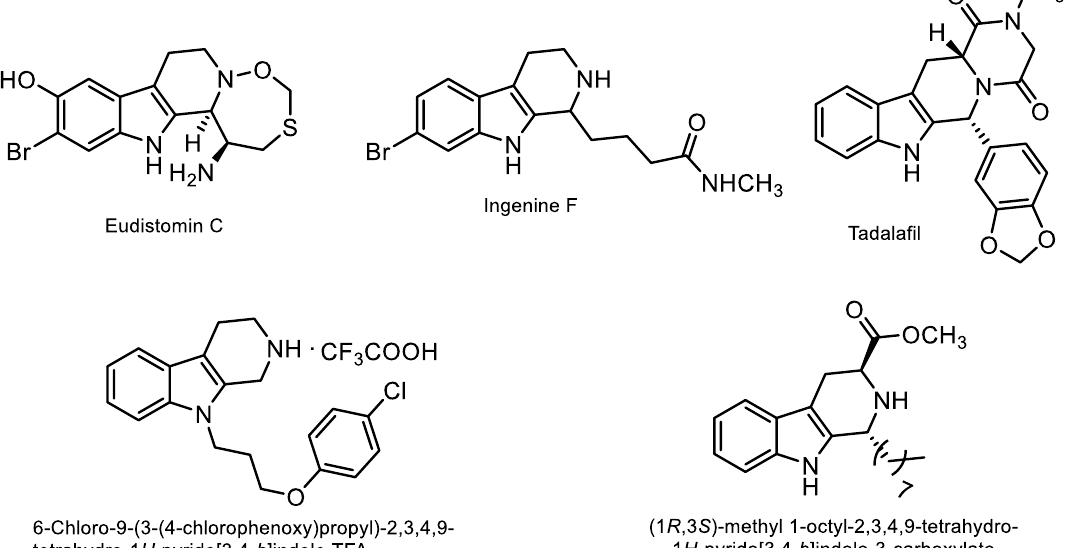
Figure 1. Chemical structures of the bioactive β -carboline